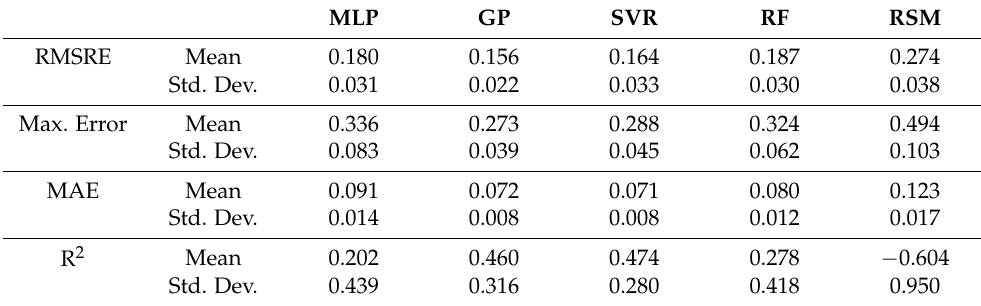
Table 4. Performance metrics values corresponding to Figure